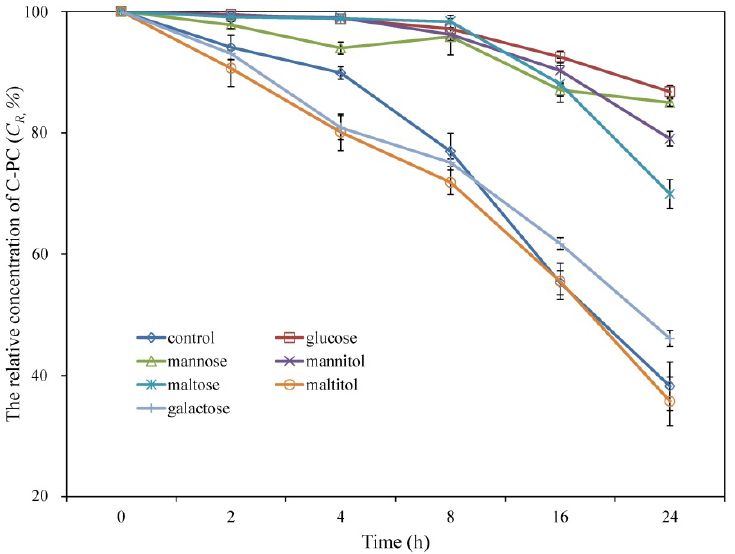
Figure 5. Change in relative concentration of C-PC treated with 20% additives and exposed to 4.5% H 2 O 2 for 24